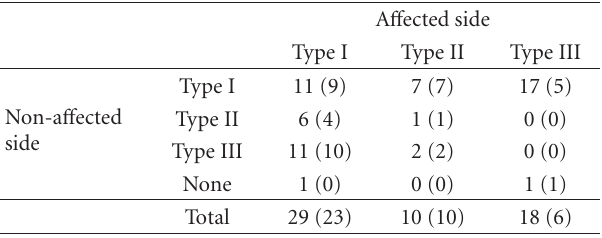
Table 2: The three types of VA with comparison of a ff ected and nona ff ected sides.